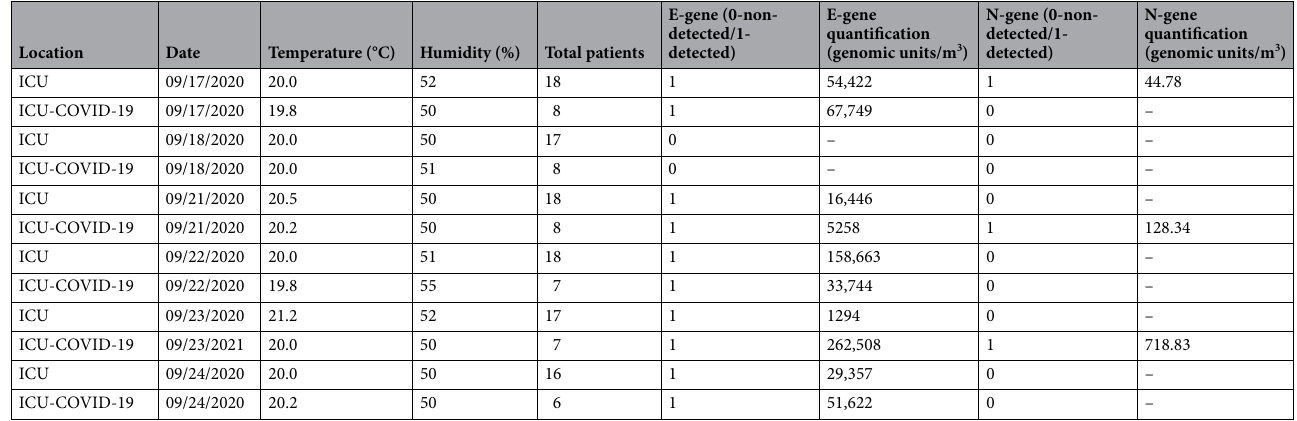
Table 1. Descriptive data of the ICUs.